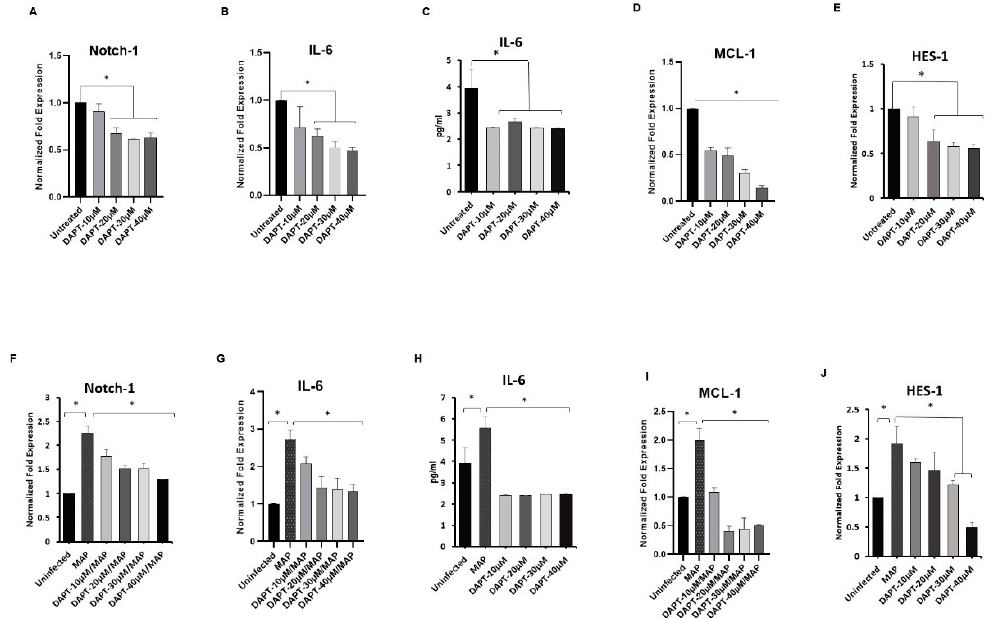
Figure 2. E ff ect of γ -secretase inhibitor (DAPT) on Notch-1 signaling. ( A–E ): Notch-1, IL-6, MCL-1 and HES-1 expression was measured in macrophages that were pre-treated with DAPT (0–40 µ M) . ( F–J ): Expression levels of Notch-1, IL-6, MCL-1 and HES-1 in THP-1-derived macrophages that were pre-treated with DAPT then infected with MAP (UCF 4, 10 7 CFU / mL) for 24 h. The gene expression levels were measured by RT-PCR. IL-6 protein level was measured using ELISA. All experiments were performed in triplets. Data are shown as mean ± SD, and significance is considered as * p < 0.05.